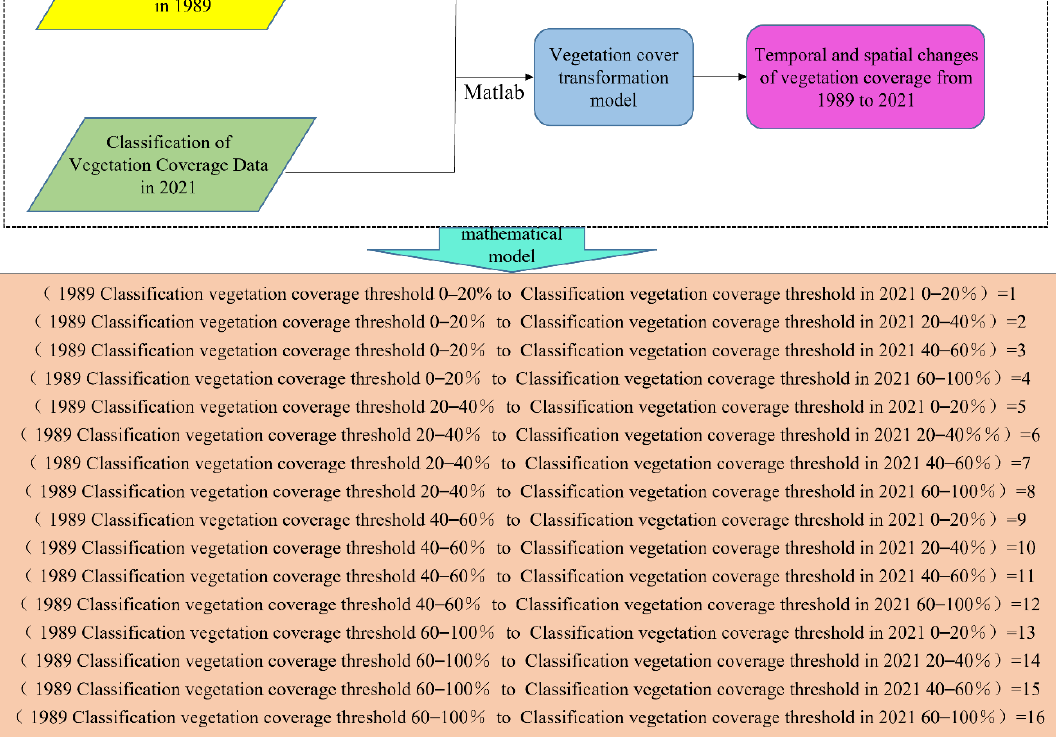
Figure 3. Vegetation cover change monitoring model operation process.